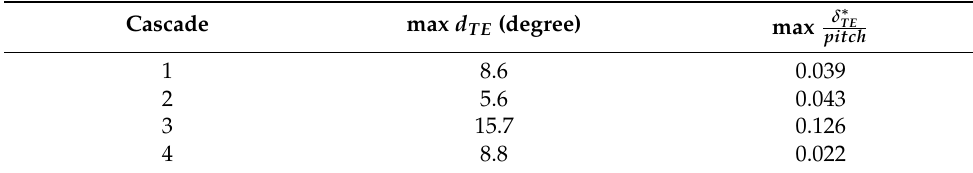
Table 5. Bladed CFD results of four cascades.